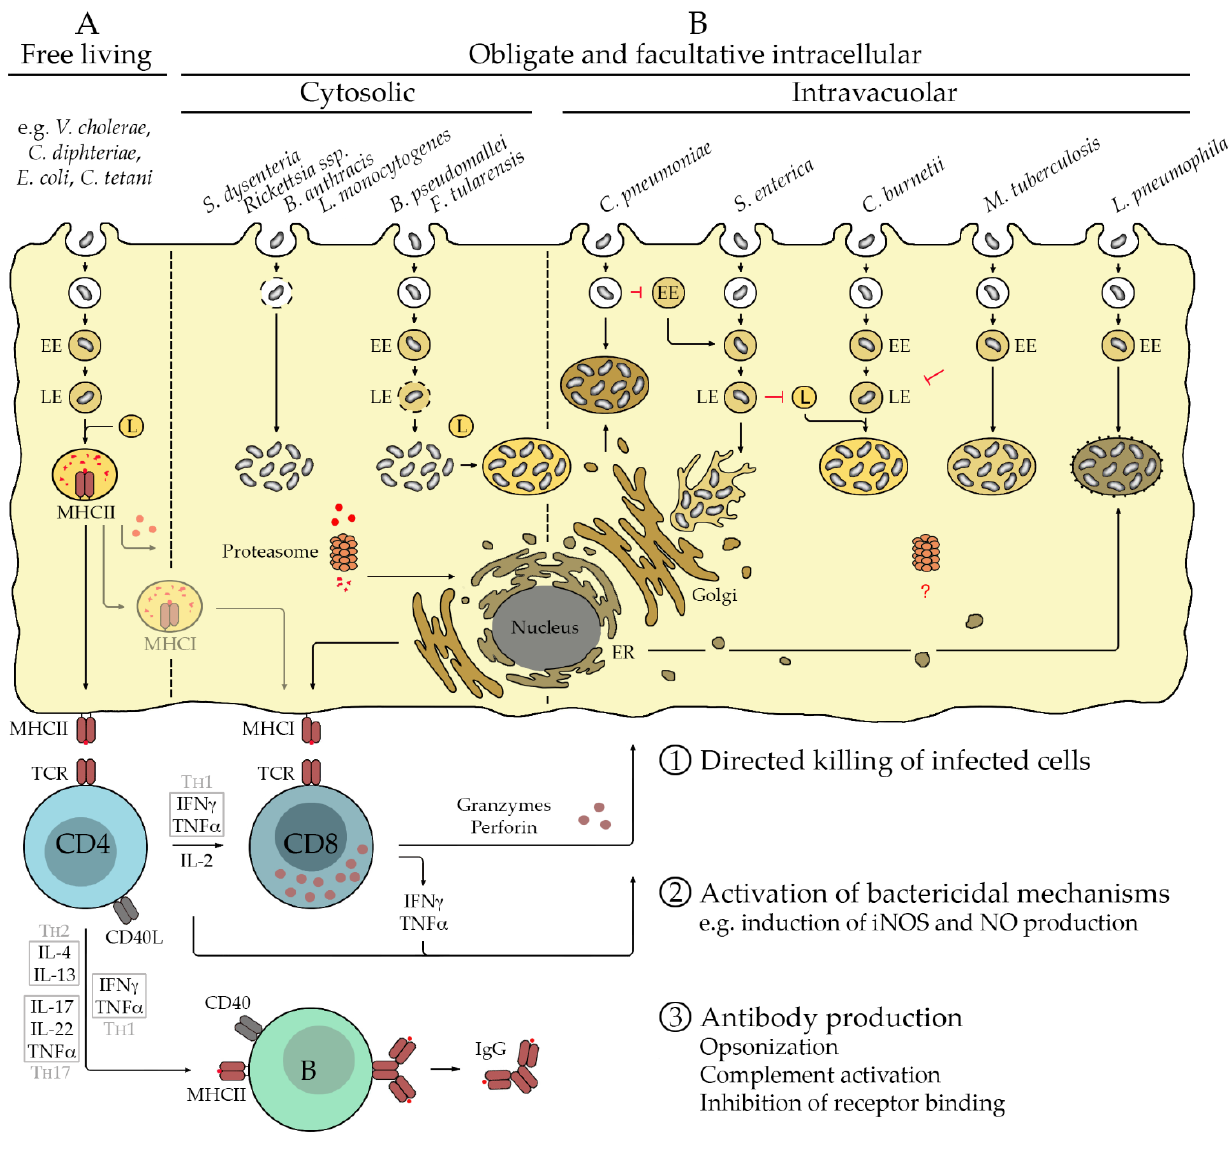
Figure 1. Extra- and intracellular bacteria and immune response. Free-living bacteria are taken up by phagocytes such as MØ and DCs as well as B cells that serve as professional antigen-presenting cells (APCs). Phagosomes develop into early endosomes (EE) and further to late endosomes (LE) that finally fuse with lysosomes (L). The activity of proteases and acidic environments of the Ls results in the degradation of the pathogen and its proteins, fragments of which are bound by MHCII molecules in the lysosomal membrane. MHCII/peptide complexes are presented on the cell surface to CD4 + T cells. The protective immune response is dominated by activated CD4 + T cells as well as B cells that produce antibodies against surface molecules of the pathogen. Depending on the cytokine environment provided by the APC, CD4 + T cells develop to T helper (T H ) cells, either to T H 2 cells producing IL-4 and IL-13, T H 1 cells that secrete IFN γ and TNF α , or T H 17 cells releasing IL-17, TNF α , and IL-22 that acts on non-immune cells. All T H cells also release IL-2, which promotes T cell proliferation and survival. Activated T H cells interact with activated B cells via the binding of CD40L to CD40 on the B cell surface, initiating the germinal center reaction where immunoglobulin class switch and affinity maturation occurs, so that high-affinity IgG instead of the initial IgM is produced. In addition, memory B cells develop. The cytokines that are produced by different T H cells promote the generation of certain IgG isotypes in this process. Antibodies can act against extracellular bacteria by opsonization for the uptake by phagocytes or direct destruction of the pathogen by complement activation. ( A ). Only a few bacteria replicate exclusively within target cells. These include members of the family of Rickettsiacea, Chlamydia ( C. ) pneumoniae , and Coxiella ( C. ) burnetii . Rickettsiae escape from the phagosome via the release of phospholipases that dissolve